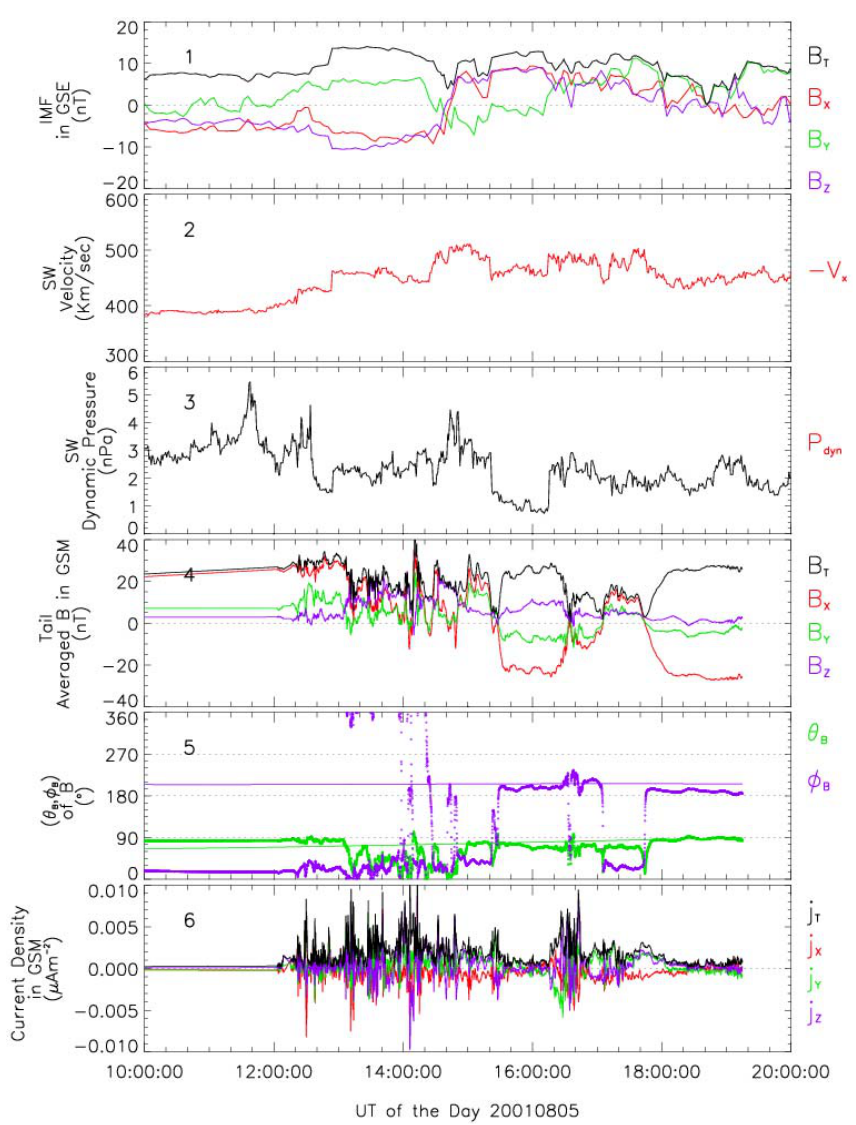
Fig. 10. The solar wind conditions as observed by ACE spacecraft and physical quantities of the tail current sheet measured by Cluster during the tail flapping event on 5 August 2001. Cluster is at 19.3 R E geocentric distance, at the nightside equatorial plane, and its polar angle θ and azimuthal angle ϕ in GSM are about 85 ◦ and 206 ◦ , respectively. The format of the figure is just same as that of Fig. 11. In panel 4–6, the data before 12:00UT are pseudo due to the unavailability of actual observation data.